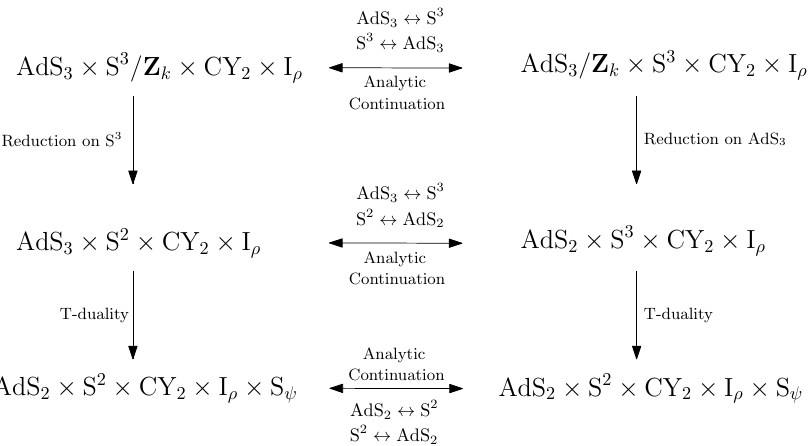
Figure 7. Connections between the different classes of solutions reviewed in this